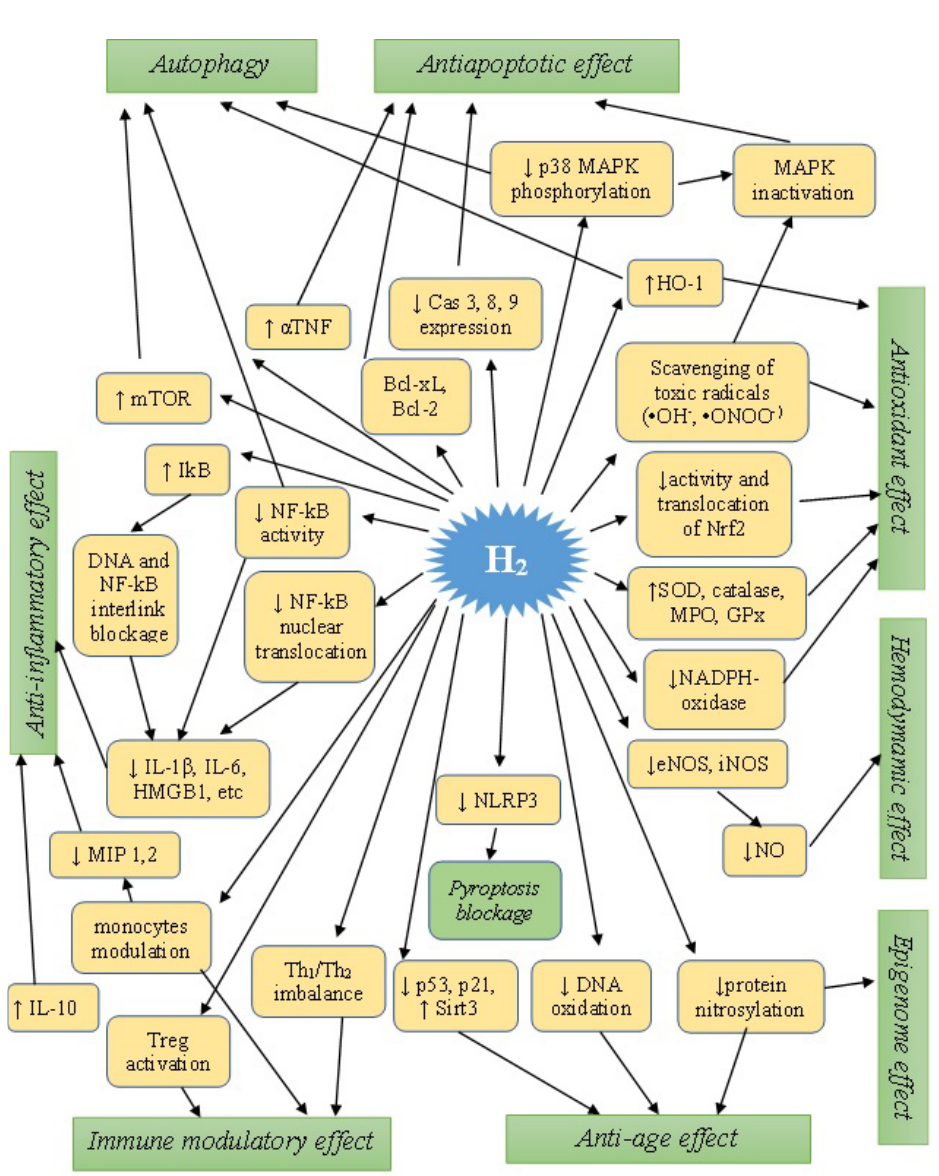
Figure 3. Molecular effects of hydrogen in living organisms. The figure shows some of the proposed mechanisms by which the main effects of hydrogen are mediated on the molecular and cellular level. The brown links represent shifts in regulatory molecules that lead to the development of specific cellular effects (indicated by green blocks). Abbreviations: MAPK–mitogen-activated protein